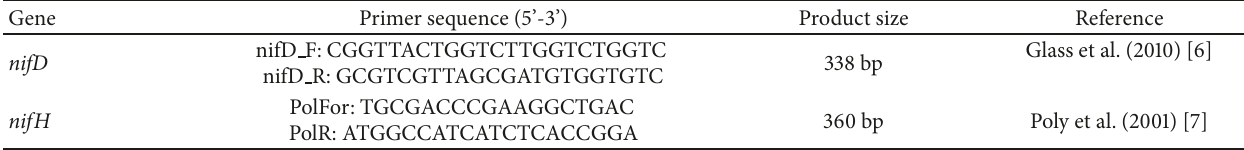
Table 1: Primers used for the amplification of nifD and nifH genes in this study.